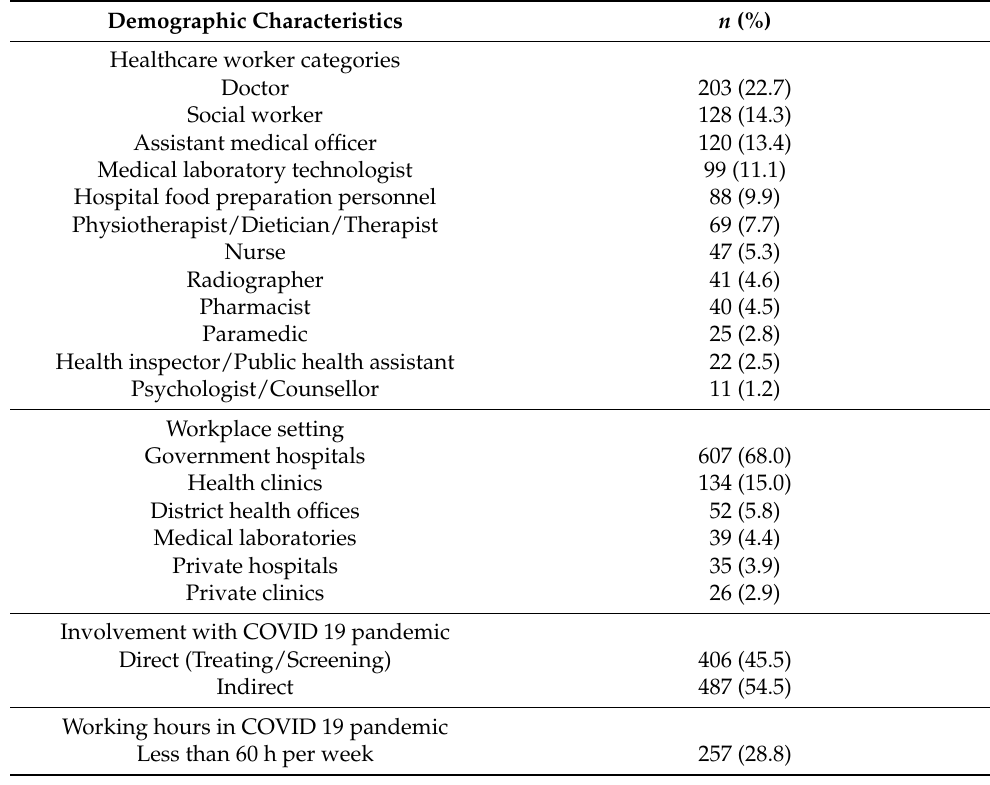
Table 1. Demographic characteristics of the healthcare workers (HCW) enrolled in the study ( n = 893). Demographic